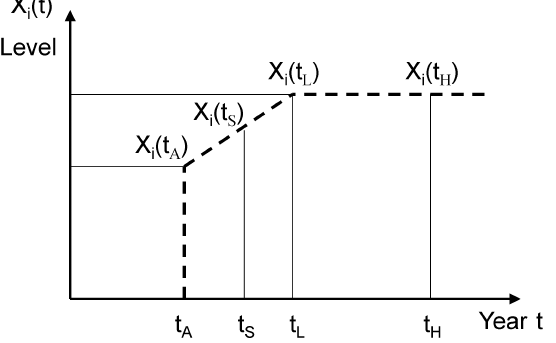
Figure 6: Instrument profile for the continuous instruments X